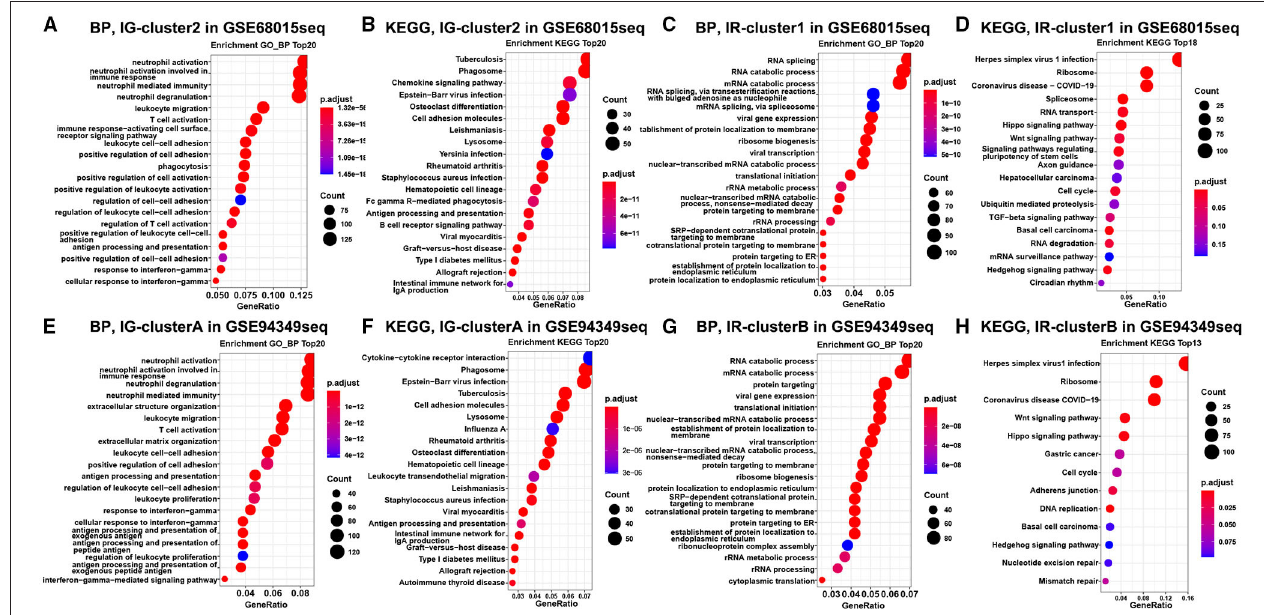
FIGURE 3 | Enrichment analysis in the IG and IR subtypes of ACPs. GO and KEGG enrichment analysis of DEGs in the cluster 1 (A,B) and cluster 2 (C,D) groups. Enrichment analysis of DEGs in the cluster A (E,F) and cluster B (G,H) groups. The top 20 items were displayed in the bubble chart.